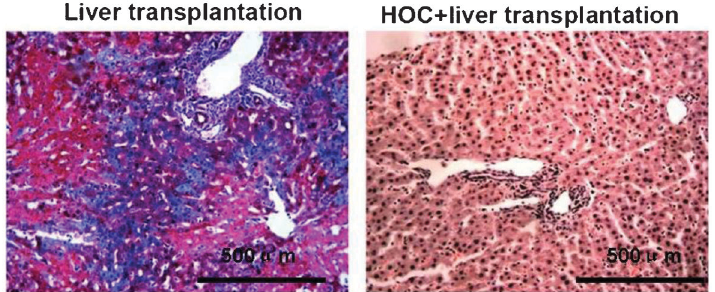
Figure 6. Histological examination of liver allo- graft rejection. Sections obtained from experi- mental groups were stained with hematoxylin &